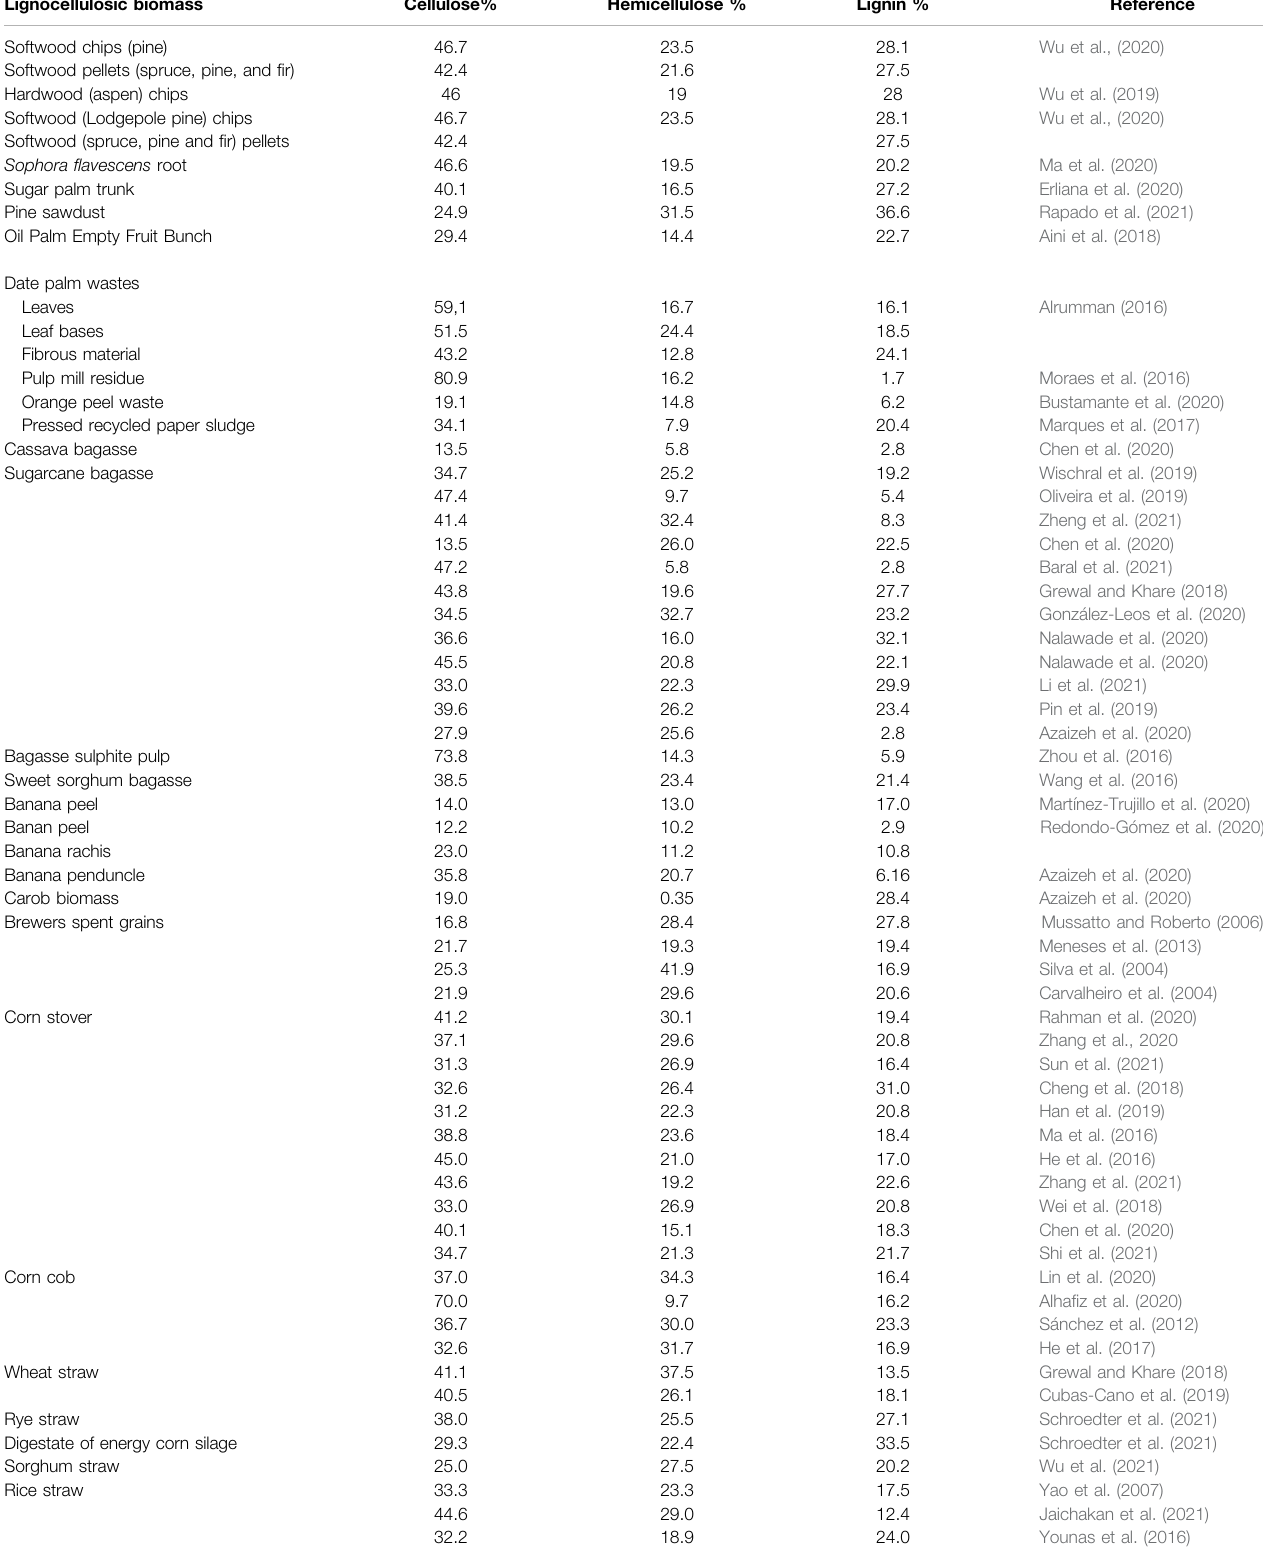
TABLE 1 | Composition of different lignocellulosic feedstocks. Lignocellulosic biomass Cellulose% Hemicellulose % Lignin % Reference Softwood chips (pine)